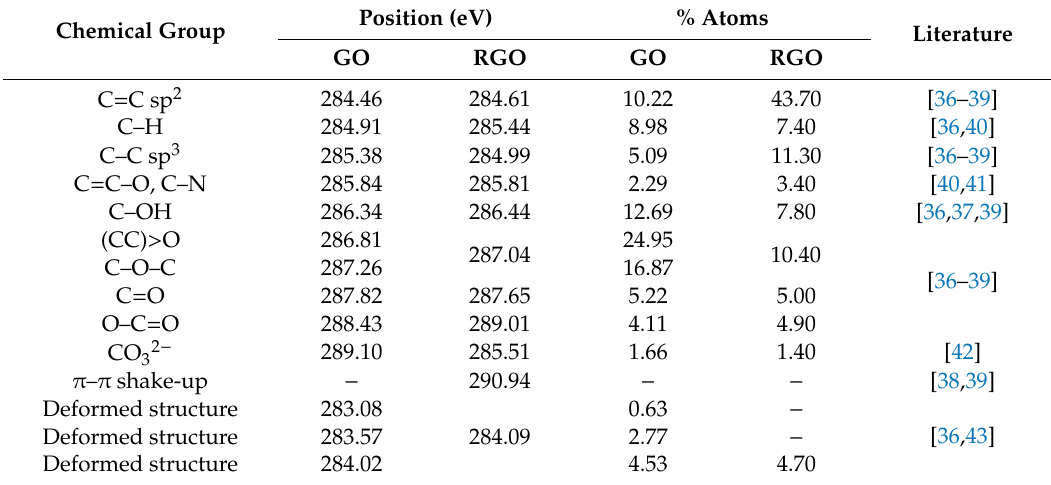
Table 2. Results of XPS C1s spectra deconvolution of GO and RGO samples.